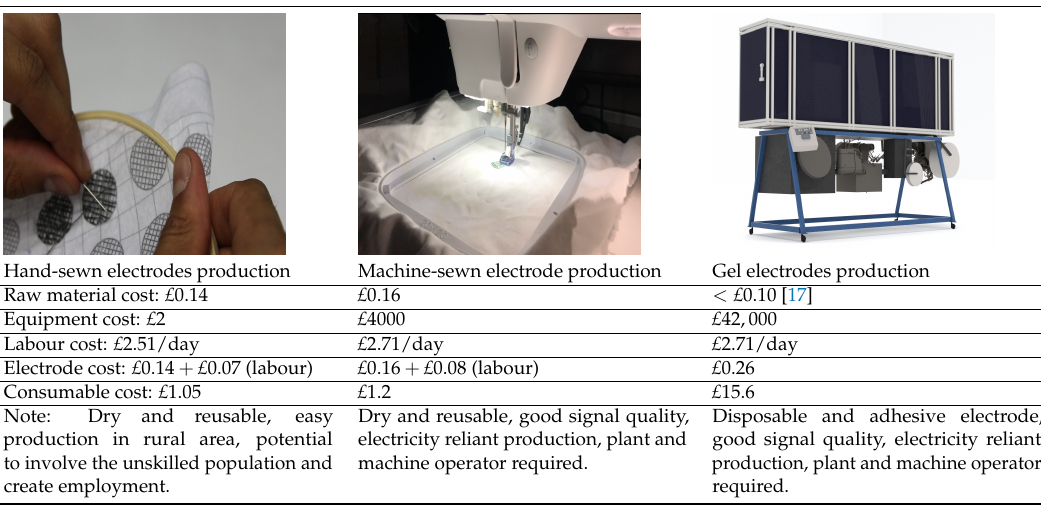
Table 1. Comparison table of electrode production and SEMG rehabilitation consumables cost for the hand-sewn electrodes, the machine-sewn electrodes and the gel electrodes. The pictures in the table show the equipment for the production of each electrode type. The labour cost estimation is taken from [9,15], representing the daily wage of a textile worker for the hand-sewn electrodes and a machine operator for the gel and machine-sewn electrodes. The estimation of consumables cost is calculated for 12 sessions of rehabilitation using the minimal setup (five electrodes required per session) [16].